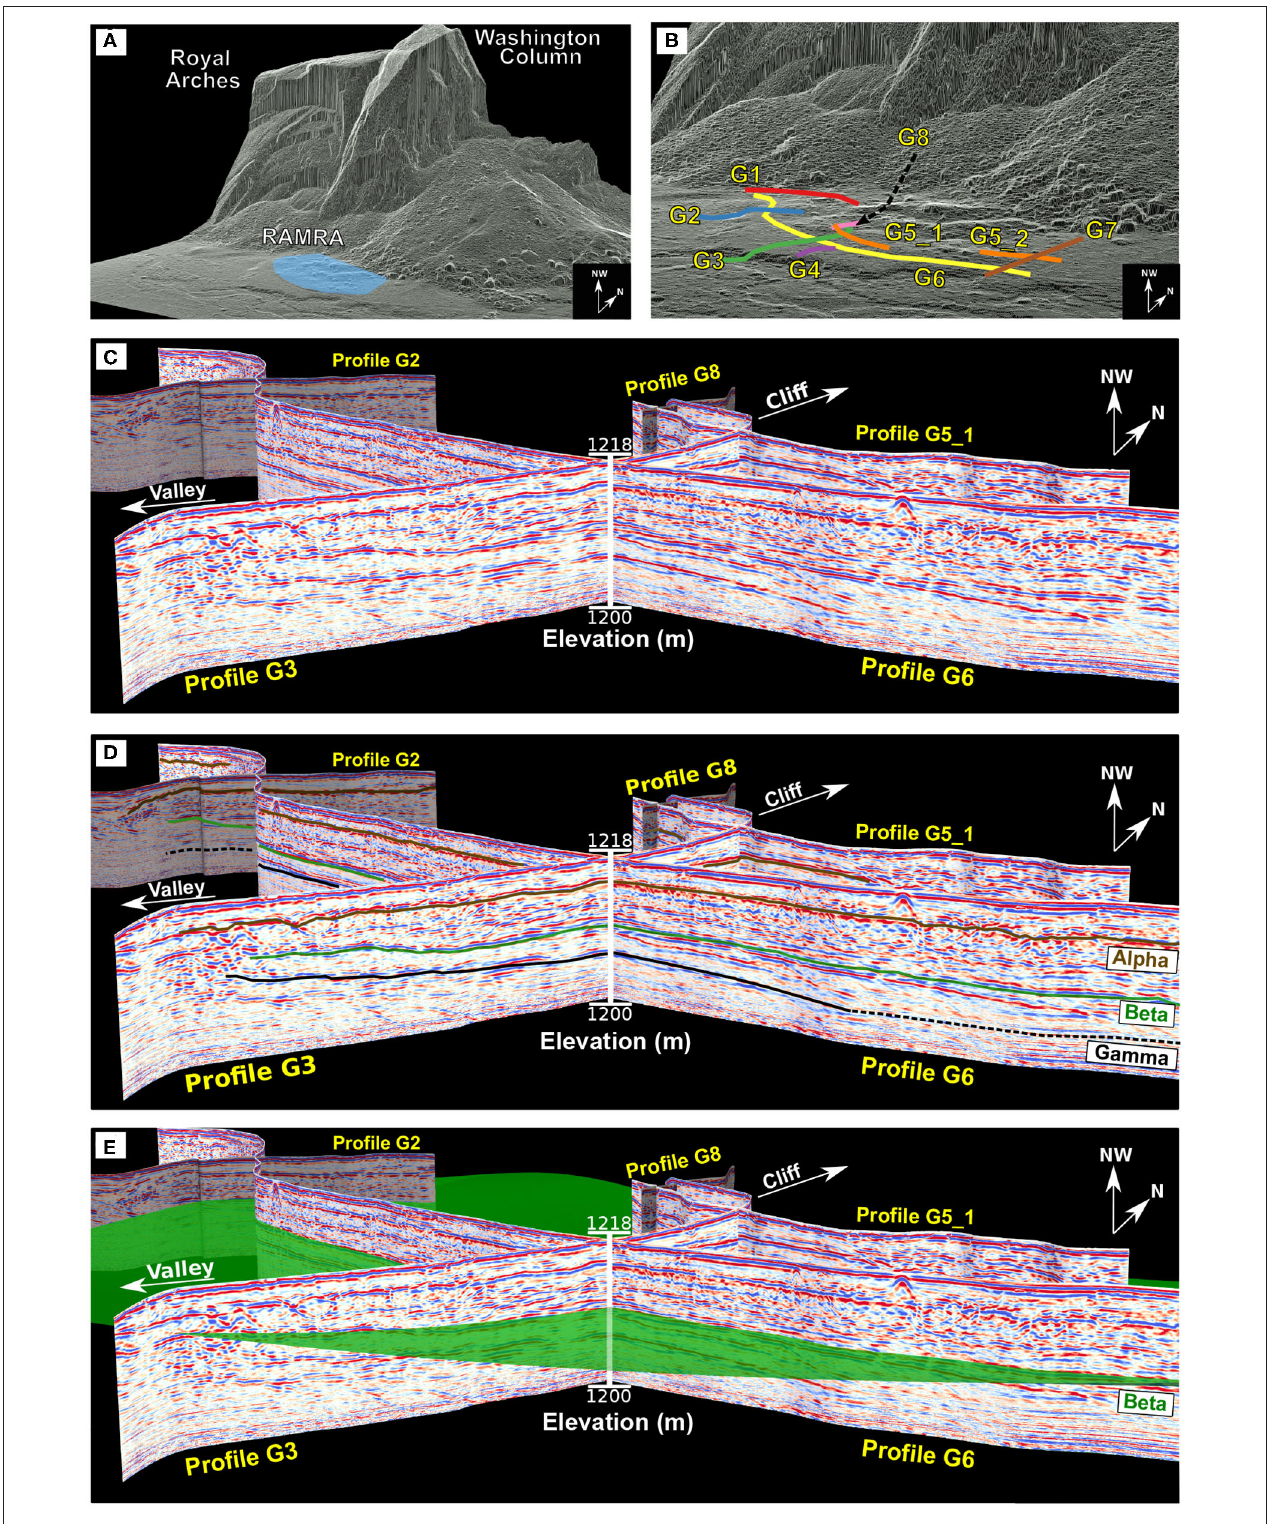
FIGURE 4 | (A) Location of the study area with respect to surrounding cliff faces. Extent of the Royal Arches Meadow rock avalanche (RAMRA) is shown in blue. (B) GPR profile arrangement within study area. (C) Oblique view of GPR profiles looking toward NW, (D) Identified interfaces Alpha , Beta , and Gamma , and (E) Interpolated surface for interface Beta